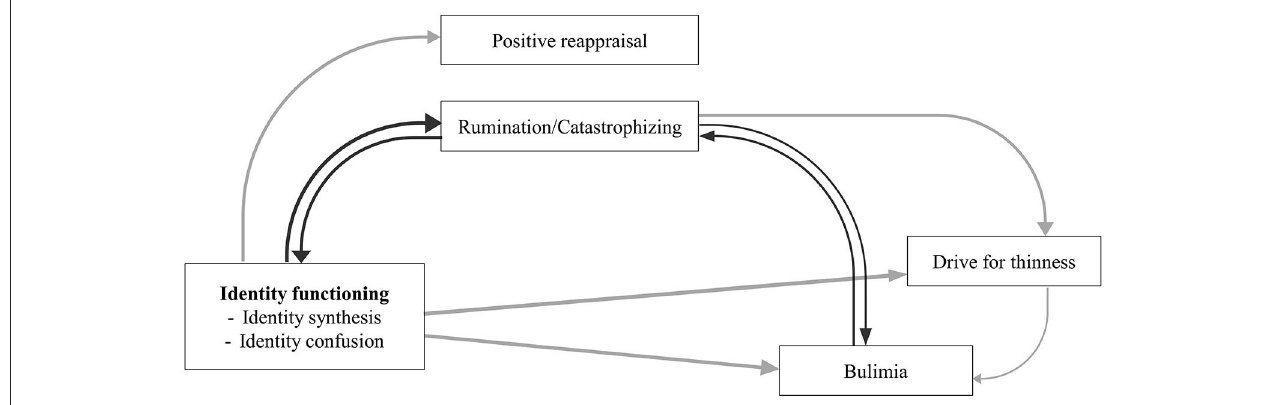
FIGURE 5 | Final model based on the cross-lagged results. Black lines represent bidirectional pathways; gray lines represent unidirectional